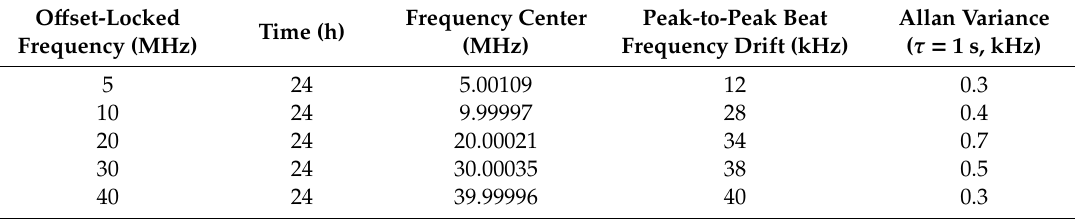
Table 1. The beat frequency drift and the relative stability at di ff erent o ff set-locked frequencies. O ff